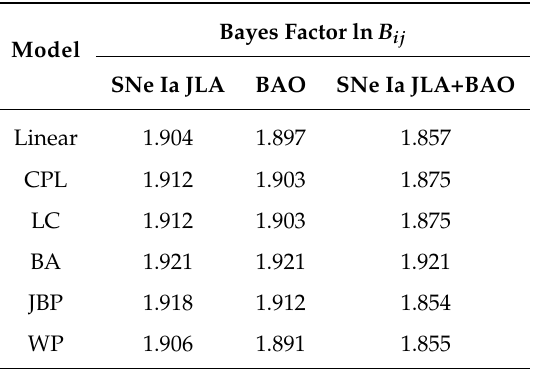
Table 4. Values of Bayes factor for each